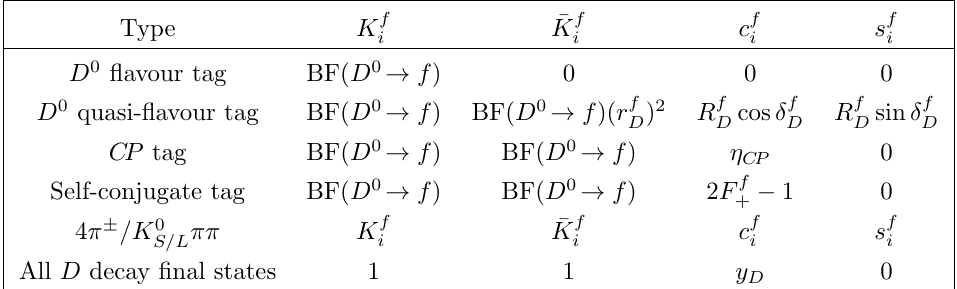
, (cid:22) K f , c f and s f parameterisation used to i i i i